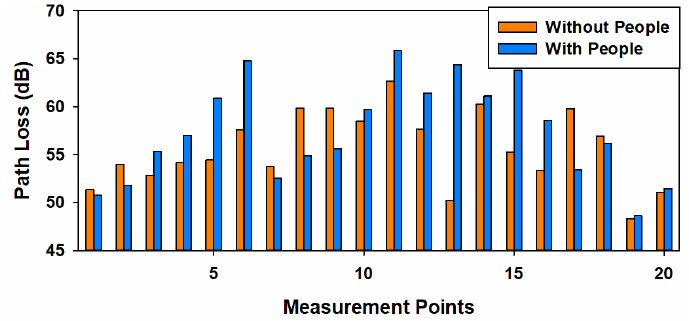
Figure 17. Received power measurements vs 3D ray-launching(3D- RL) simulation comparison.